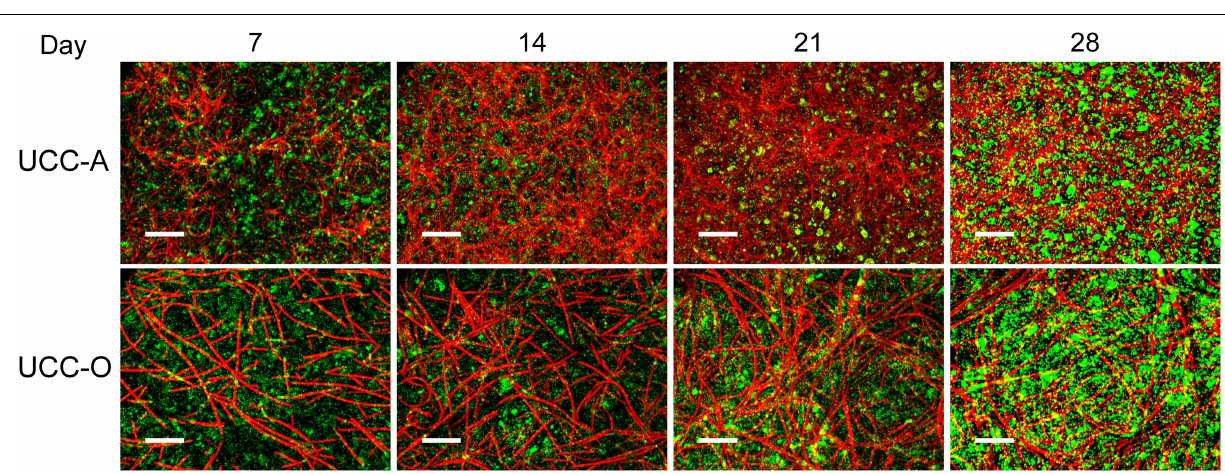
FIGURE 6 | Assembly of UCC-A and UCC-O biofilms. Images are z -projections of stacks of images spanning the entire biofilm structure at a 1 μ m step size and represent growth of the consortia on days 7, 14, 21, and